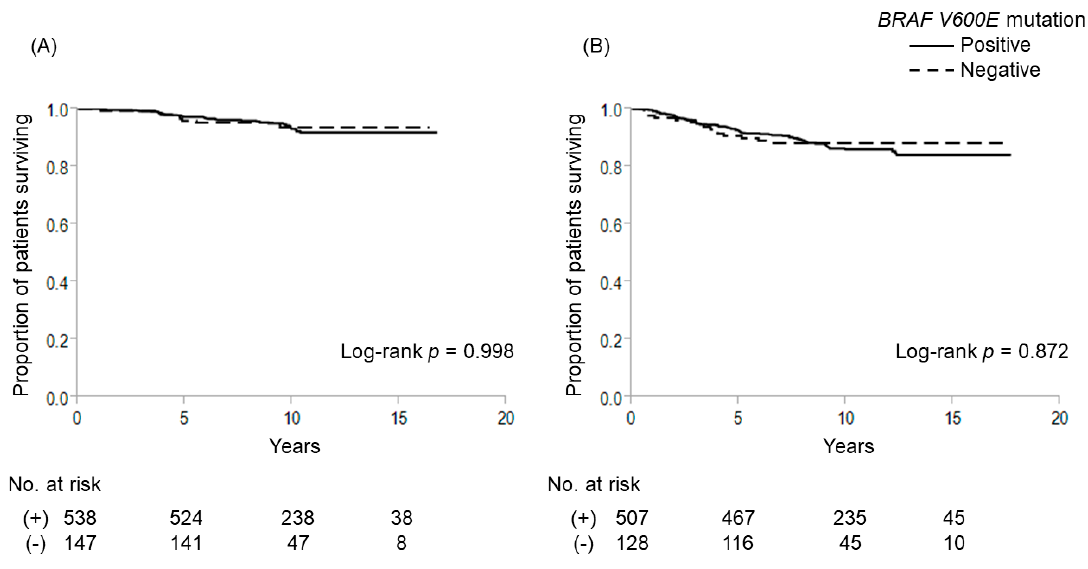
Figure 1. Cause-specific and disease-free survival curves for patients with or without BRAF V600E mutation. ( A ) Cause-specific survival; ( B ) disease-free survival.